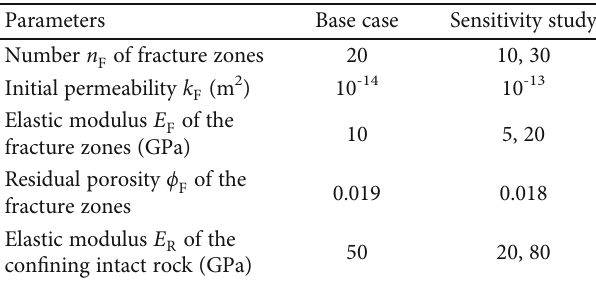
Table 2: Parameters considered in the base case and sensitivity